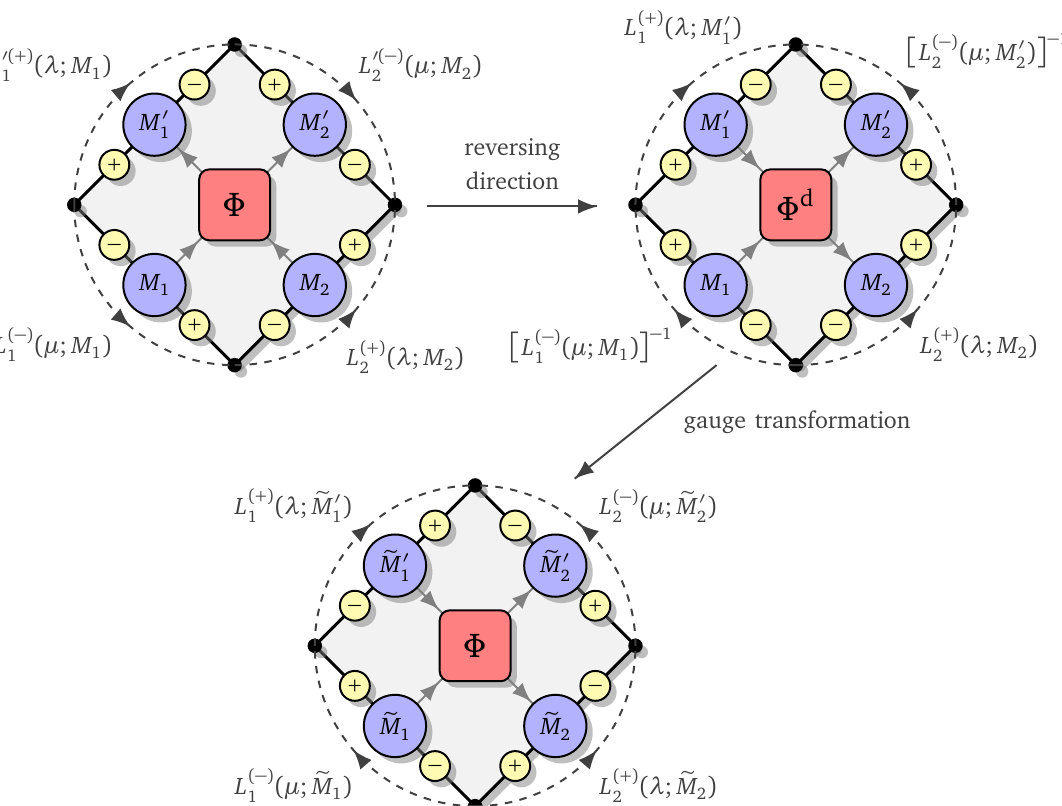
Figure 3: Space-time self-duality: parallel transport in the ‘space-like’ direction as- sociated with the temporal propagator Φ τ (top left panel) can be interpreted as the ‘time-like’ parallel transport by inverting the Lax matrices along the ‘negative’ light- cone axis (top right panel) which defines the dual (i.e. spatial) propagator Φ d canonical form can be recovered by additionally applying a gauge transformation on the matrix variables (bottom panel), thus establishing a duality between the temporal and spatial